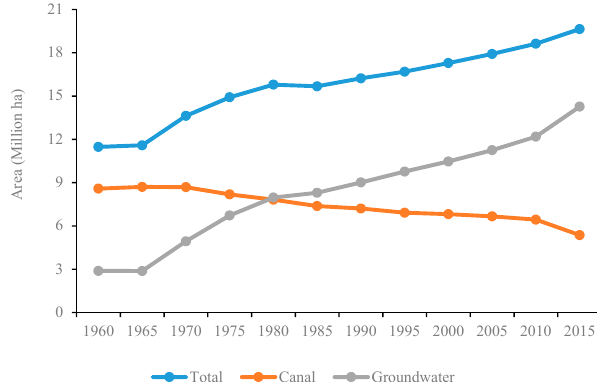
Figure 4. Groundwater use patterns in Pakistan (Source: Pakistan Statistical Bureau).